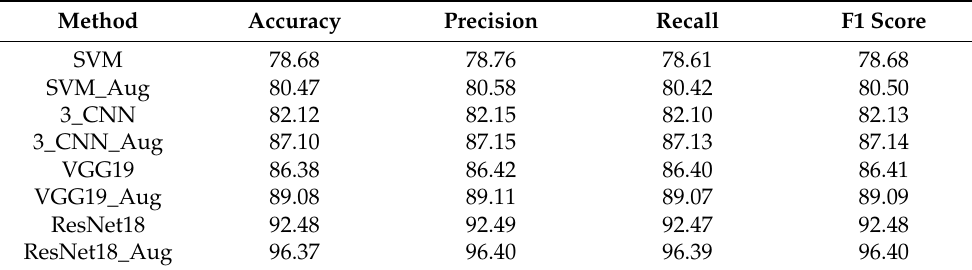
Table 3. Accuracy comparison (%) for the MFCC by different methods.